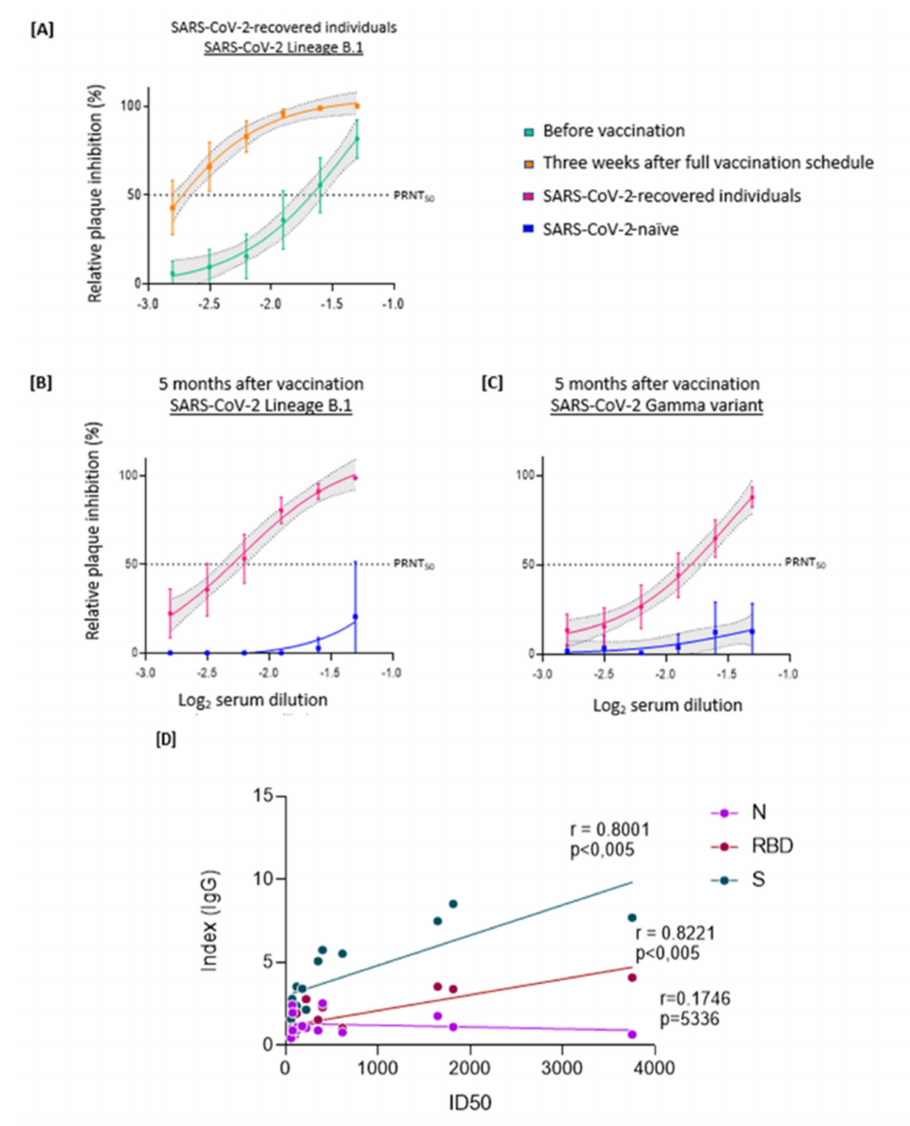
Figure 3. Virus-neutralizing antibodies against SARS-CoV-2 lineages B.1 and Gamma variant in SARS-CoV-2-naïve or previously infected vaccinated individuals. The PRNT50 represents the highest sample dilution that showed capacity to reduce by 50% the viral plaque formation based on control wells inoculated with SARS-CoV-2 without serum. Each point represents the mean of all plasma samples at each dilution, shown as log10; error bars represent 95% CI. ( A ) Sera from COVID19- recovered individuals were evaluated in two timepoints: before vaccination and three weeks after the second dose against lineage B.1 (underlined). Sera from either naïve or previously infected individuals were analyzed for their virus-neutralizing capacity, five months after full vaccination, against the virus B.1 lineage (underlined) ( B ) or Gamma variant (underlined) ( C ). ( D ) Correlation of PRNT 50 with IgG index against S glycoprotein (r2 = 0.6401), RBD (r2 = 0.6758), and N protein (r2 = 0.03051) (Spearman’s correlation, r; a linear regression was used to calculate the fit,